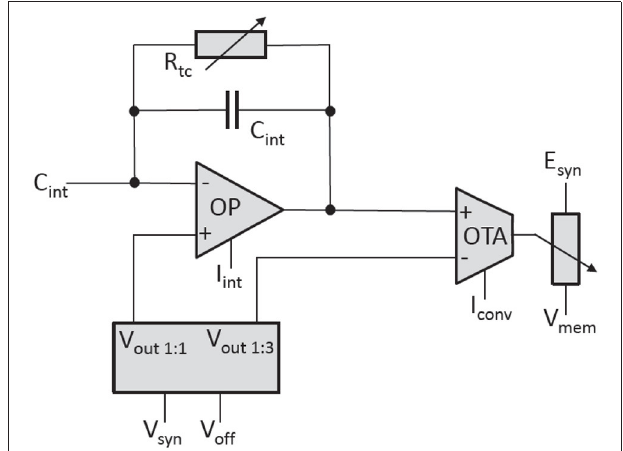
FIGURE 12 | Simplified circuit diagram of the synaptic input of the neuron.